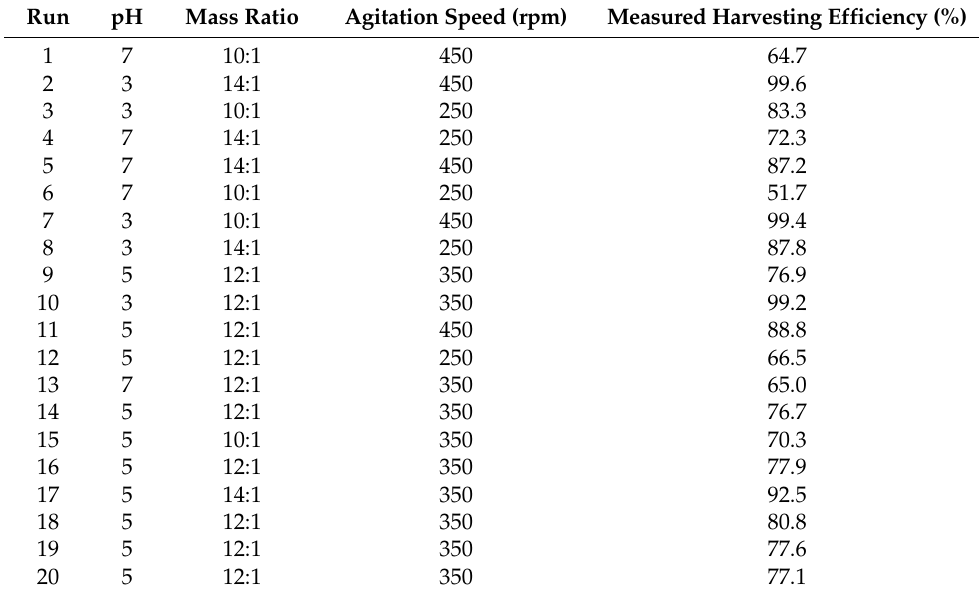
Table 2. Design table formed by RSM—CCD, presenting the experimental conditions and the experimental values of harvesting